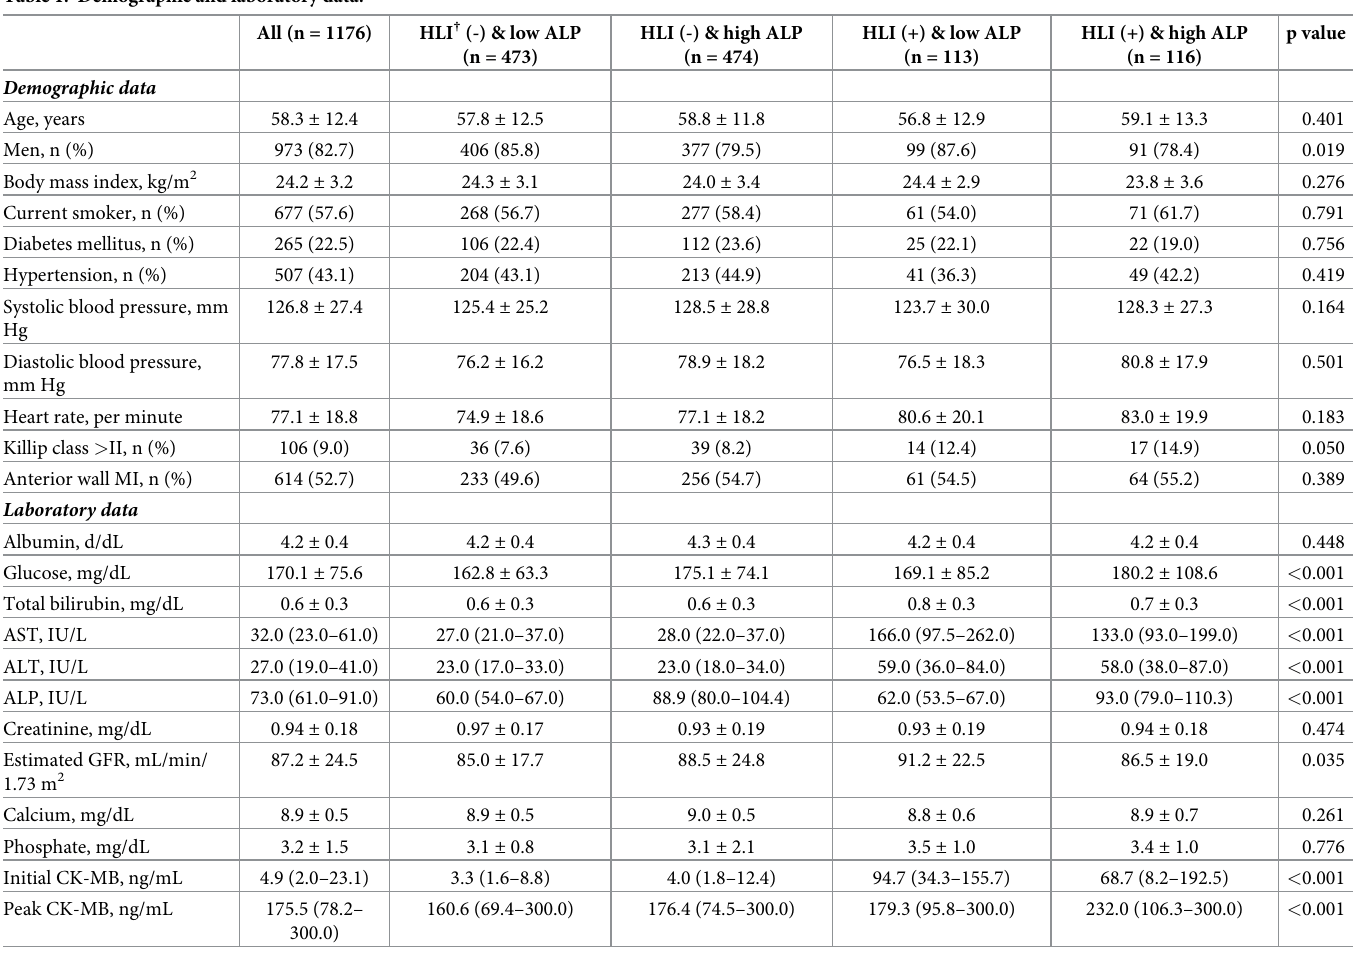
Table 1. Demographic and laboratory